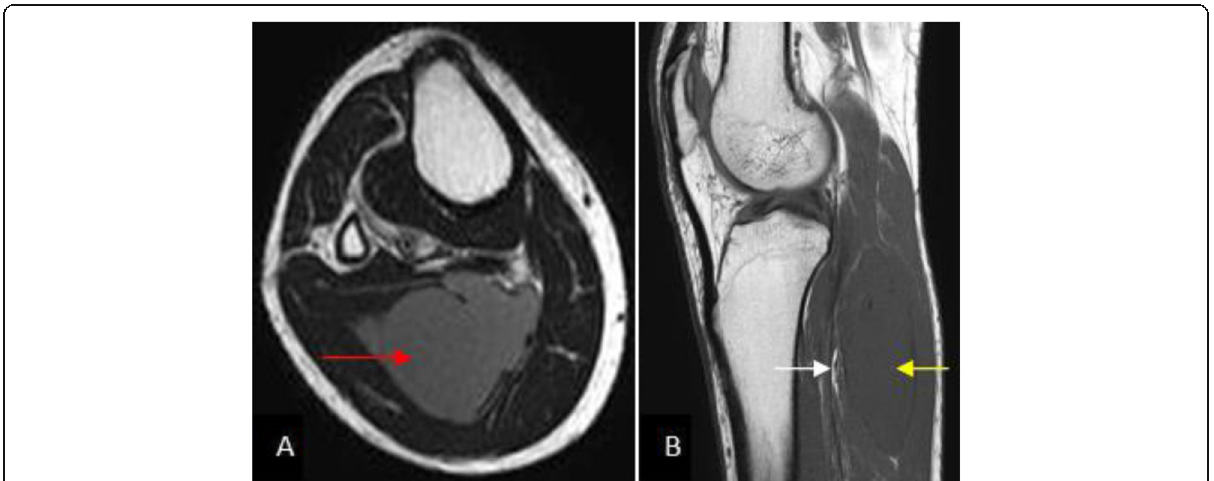
Fig. 2 Thirty-year-old male with lymphangioma in the proximal leg along the posterior aspect. Findings: FLAIR axial ( a ) and T1WI sagittal ( b ) images showing the lesion in the intermuscular plane which appears as a low signal on T1WI (yellow arrow) and shows homogenous suppression on FLAIR (red arrow). Fat plane is maintained with the adjacent muscles (white arrow). Technique: Philips Insta 1.5-T MRI — FLAIR axial: TR 11,000 ms, TE 120 ms, TI 2800 ms, matrix 256 × 144 and slice thickness 3 mm; T1WI axial: TR 522 ms, TE 18 ms, matrix 380 × 258 and slice